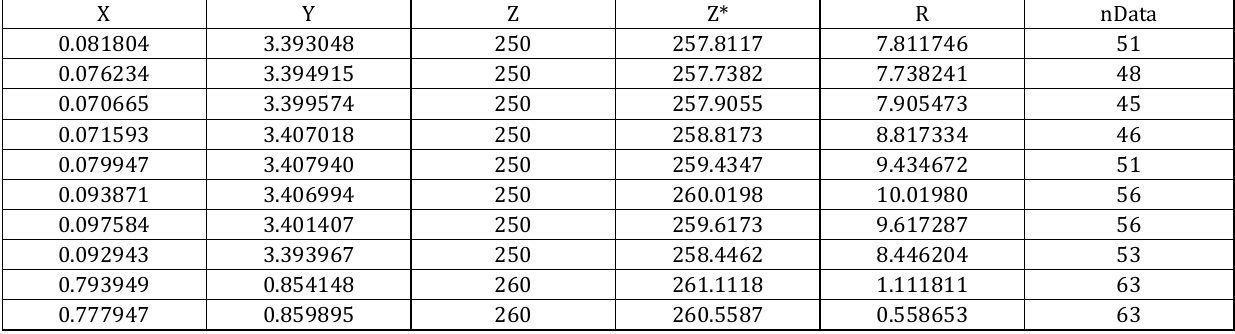
Table. 4. Parameters of 10 selected sampling points received as a result of cross-validation usage based on incorrect variogram